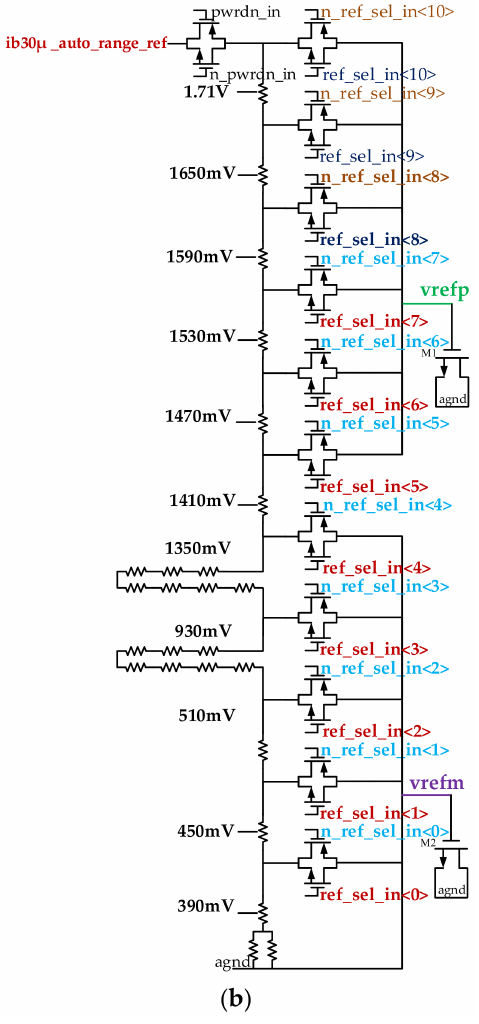
Figure 2. ( a ) Proposed PLL with an automatic band selection circuit; ( b ) four-bit ADC sub-block with two indigenous custom voltage